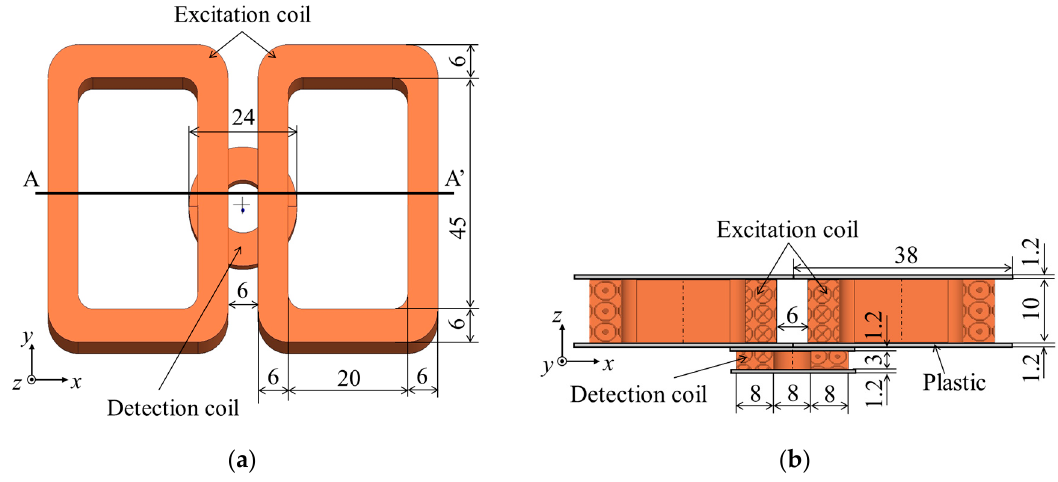
Figure 1. Structure of butterfly probe (units in mm); the number of turns in each excitation coil is 1000: ( a ) top view; ( b ) section view of A-A’.